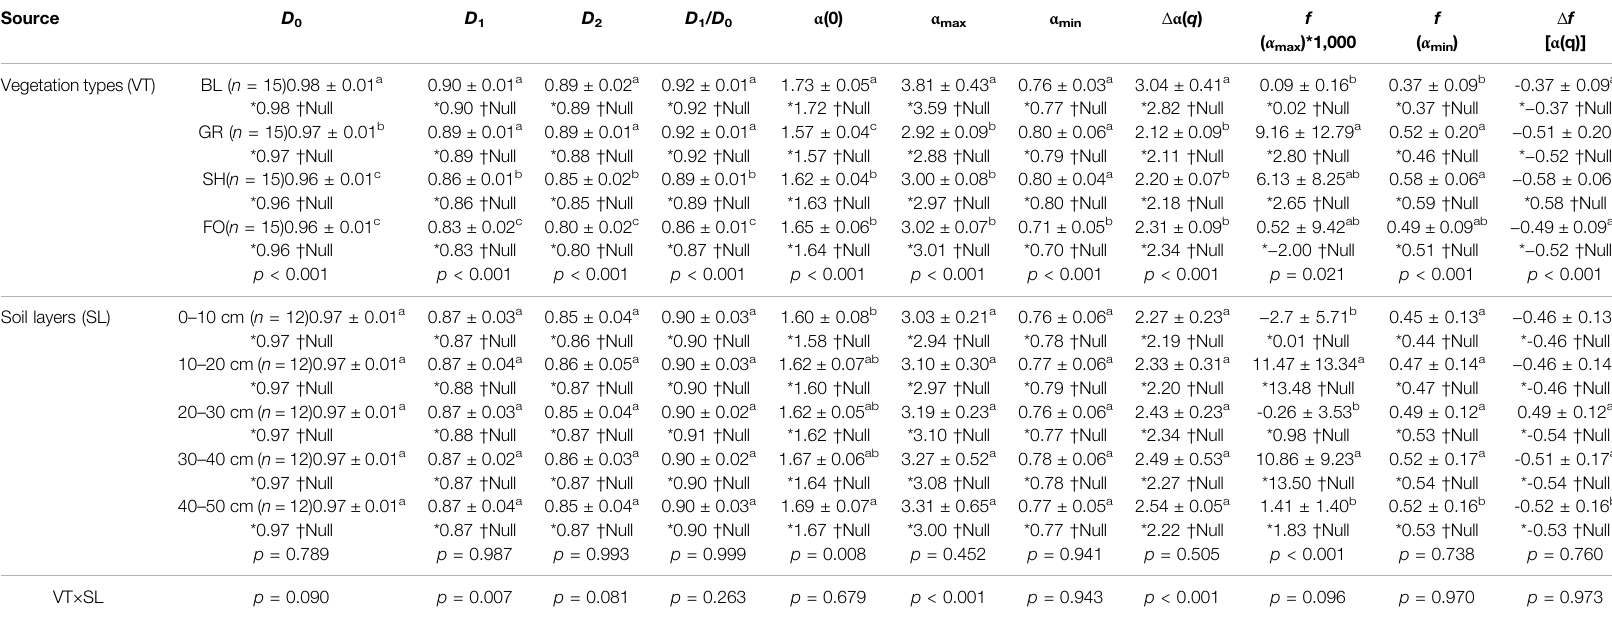
TABLE3| Multifractal parameters amongfourvegetation types and fi vesoillayers.BL: Bareland;GR: Grassland; SH:Shrub;FO: Forest; D 0 :Capacity dimension; D 1 :Entropydimension; D 2 :Correlation dimension; α (0):the average value of multifractal singular spectrum; α max : the maximum value of singularity index; α min : the minimum value of singularity index; Δ α (q): singularity index; f ( α max ): multifractal spectrum value in α max ; f ( α min ): multifractal spectrum value in α min ; Δ f [ α (q)]: the shape of multifractal spectrum. Different letters indicate signi fi cant differences at p < 0.05. All data are shown using mean ± standard error. * means median; † means mode. Source